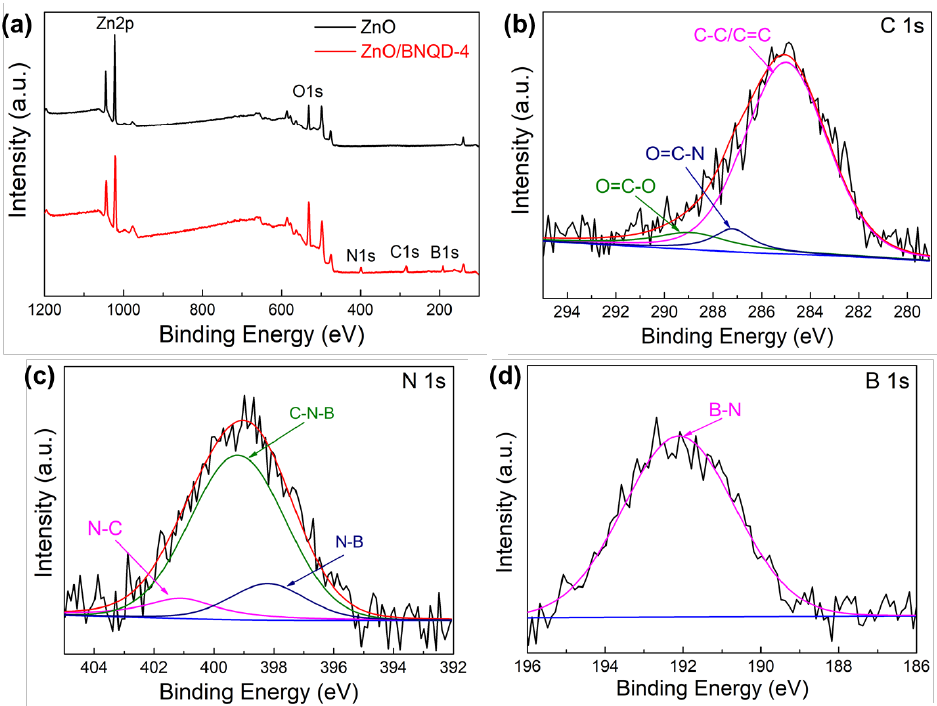
Figure 3. ( a ) XPS survey scan of ZnO and ZnO/BNQD-4 samples. ( b – d ) High-resolution C1s, N 1s, and Zn 2p spectra of ZnO/BNQD-4, respectively. and Zn 2p spectra of ZnO/BNQD-4,